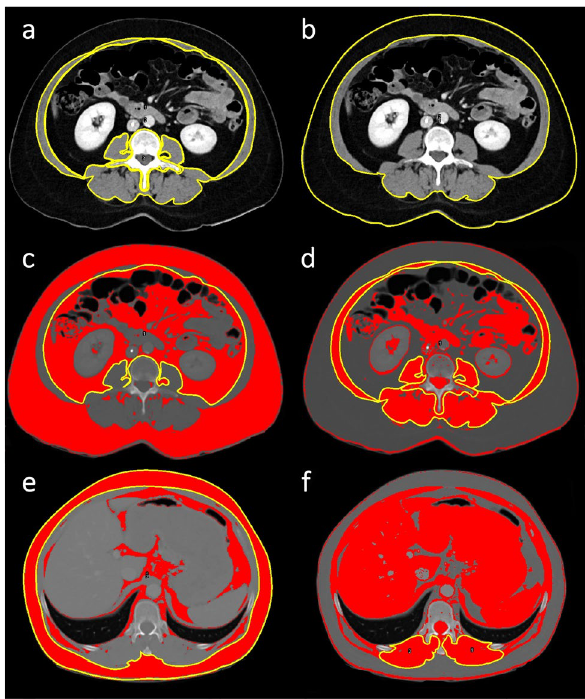
Figure 1. Regions of interest (ROI) for fat and muscle measurements on axial CT images. Measurements were performed on axial slices of contrast-enhanced CT scans of the thorax and abdomen at the level of the third lumbar vertebra (L3) ( a – d ) and the twelfth thoracic vertebra (T12) ( e – f ) with a muscle-specific (− 29 to + 150 Hounsfield units (HU)) and fat-specific threshold (− 190 to − 30 HU), respectively. Image ( a ) and ( b ) are pictured without the threshold to allow better visibility of anatomic structures. For the skeletal muscle area (SMA) at L3, the area of the ROI around L3 and of that around the abdominal muscles’ inner circumference were subtracted from the area of the ROI along the outer muscles’ circumference according to Gomez- Perez et al. 25 ( a ). For the subcutaneous fat area at L3 and T12 the area of the ROI along the outer muscles’ circumference was subtracted from the area of the ROI around the waist circumference ( b , e ). For the visceral fat area, a ROI was drawn along the inner circumference of the abdominal muscle ( c ). The circled muscles used to determine the muscle radiodensity attenuation (MRA) at L3 are shown in ( d ). For the SMA and MRA at T12, because of a potential measurement bias caused by the ribs, ROIs were defined along the posterior paraspinal muscles’ circumference ( f